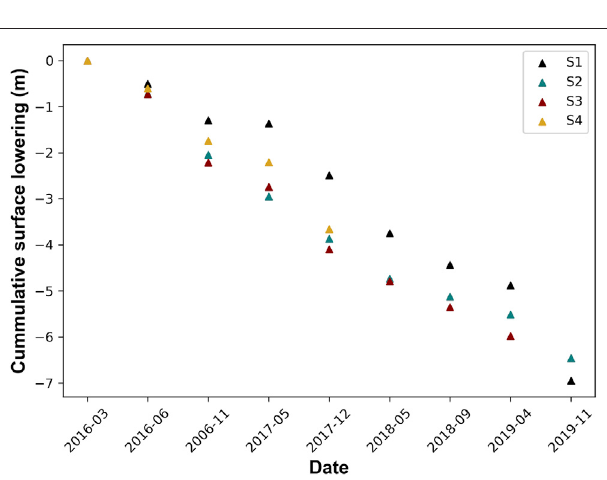
FIGURE 6 | Cumulative surface lowering measured from March 2016 to November 2019 at four stakes installed on the lower part of Ponkar Glacier (locations are shown on Figure 1B and their characteristics listed in Table 2 ). Ablationmeasurementswerenotavailablefromthehigheststake(S4)for 2017 and